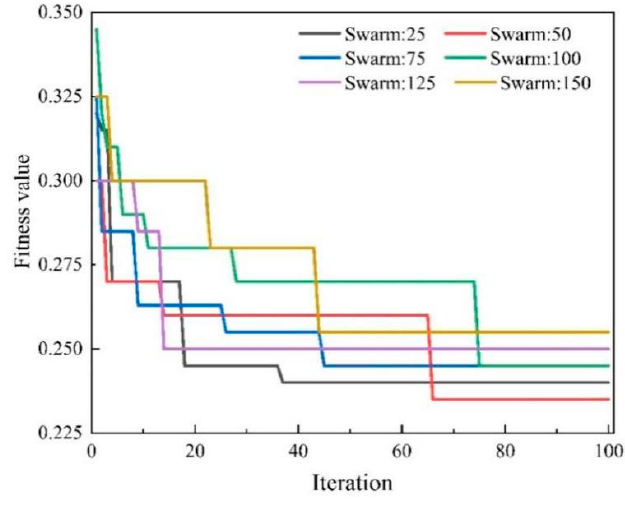
Figure 6. Optimization of the WOA–RF model with different population Figure 6 . Optimization of the WOA–RF model with different population values .